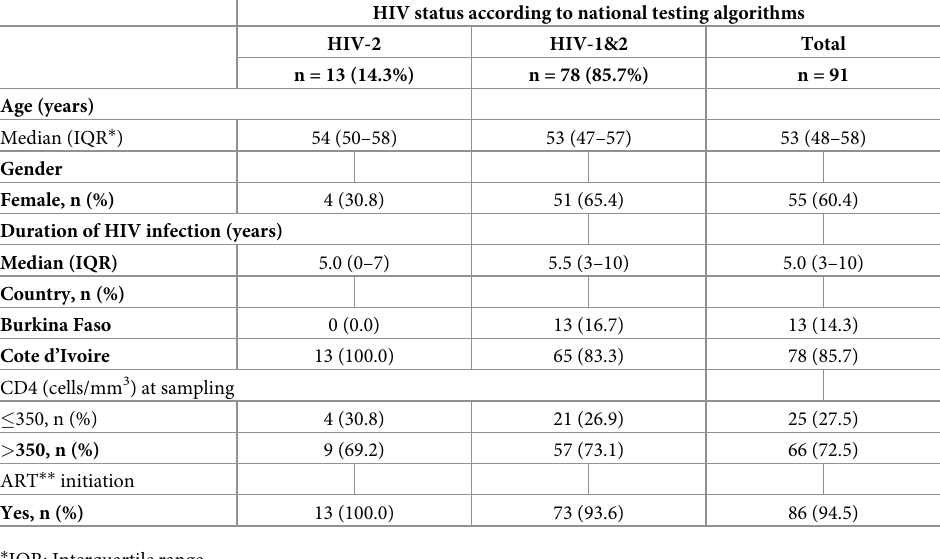
Table 1. Demographic characteristics of participants according to initial HIV status based on national HIV test- ing algorithms in West